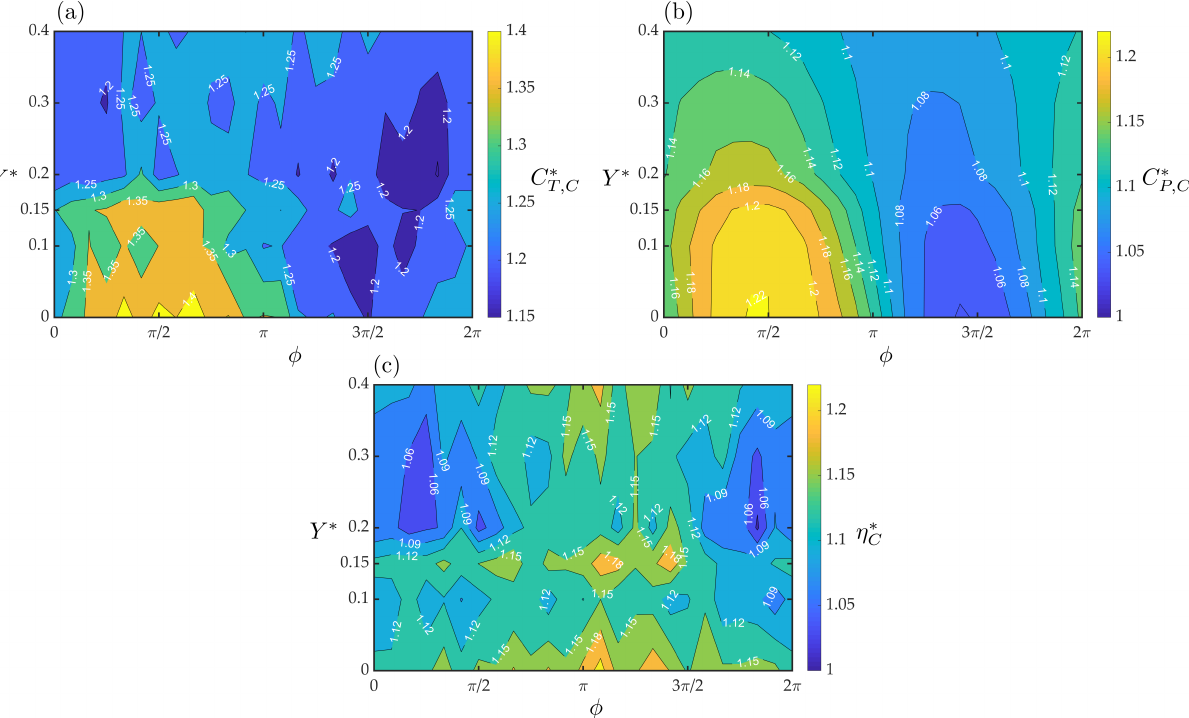
Figure 5. Normalized collective ( a ) thrust, ( b ) power and ( c ) efficiency as a function of synchrony and cross-stream spacing between the leader and